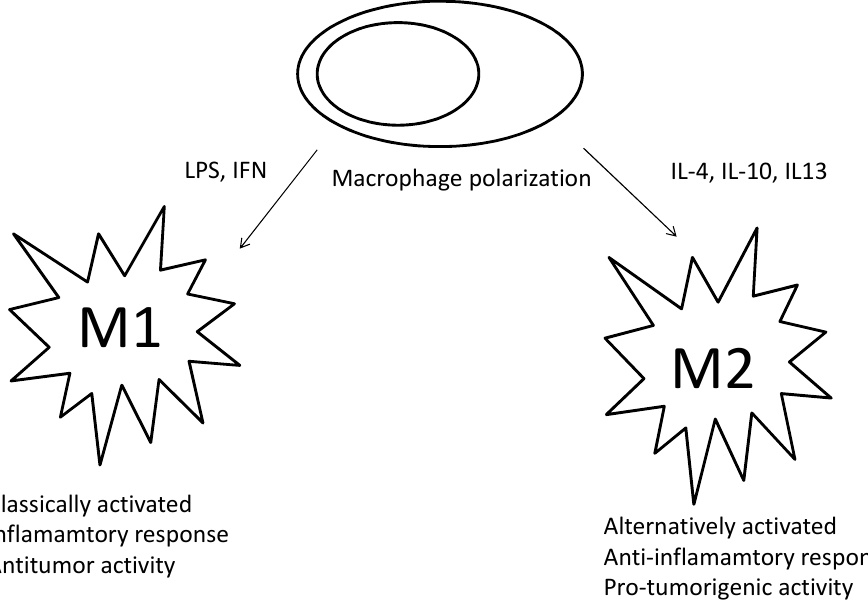
Figure 2. Visual mean of tumor-associated macrophages polarization.